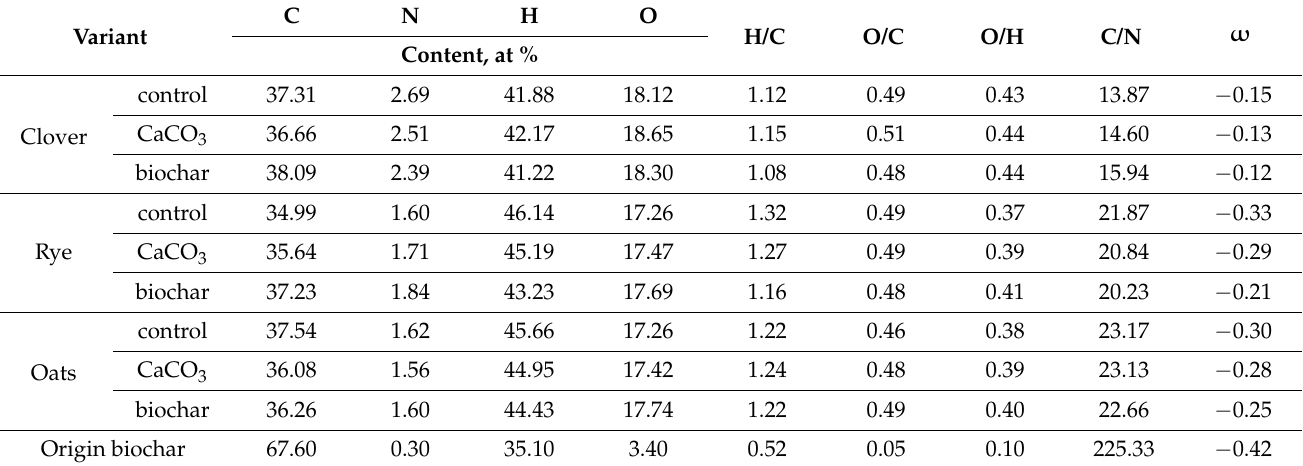
Figure 3. The index of optical density of humic acids formed during plant residues decomposition: ( A )—30 days, ( B )—90 days (the same small letters mean no significant differences between the values at the level of significance p < 0.05, n = 4; one-way ANOVA, Student-Newman-Keuls test). Table 4. The elemental composition, atomic ratio, and oxidation degree of humic acids (HAs1 + HAs2) and initial biochar.